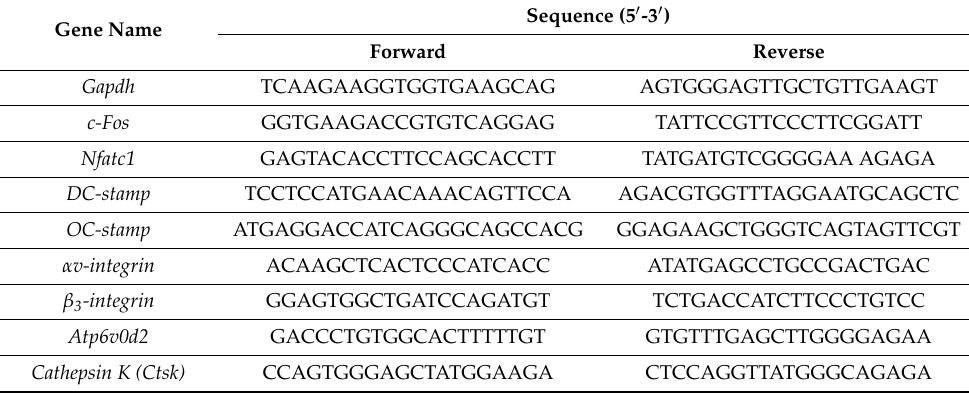
Table 1. Primer sequences used for real-time qRT-PCR